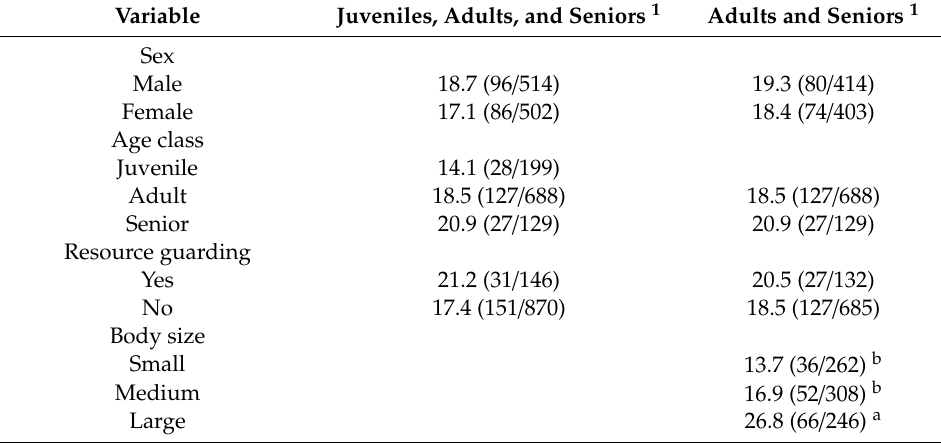
Table 3. The percentages of adopted dogs returned to the shelter in relation to sex, age class, resource guarding status, and body size. The number of dogs returned / number of dogs adopted shown in parentheses. Within columns and specific variables, values with di ff erent superscript letters are significantly di ff erent ( p ≤